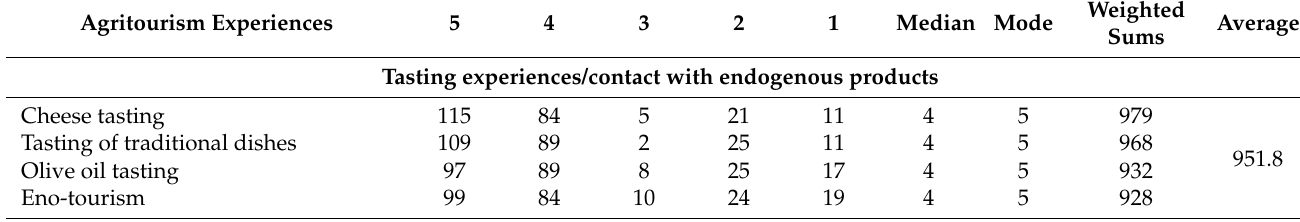
Table 7. Agritourism experiences